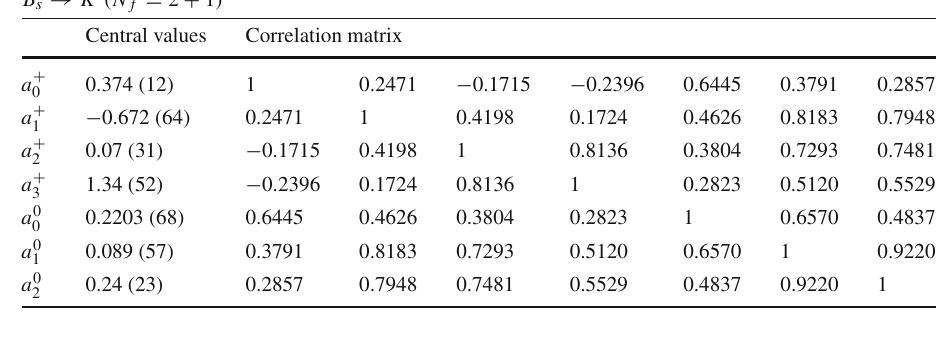
correlation matrix for the N + = N 0 = 4 z -expansion of the B s → K form factors f + and f 0 . The coefficient a 0 is 3 fixed by the f + ( q 2 = 0 ) = f 0 ( q 2 = 0 ) constrain. The chi-square per degree of freedom is χ 2 / dof = 1 . 54 and the errors on the z -parameters have been (cid:10) χ 2 / dof = 1 . 24 rescaled by